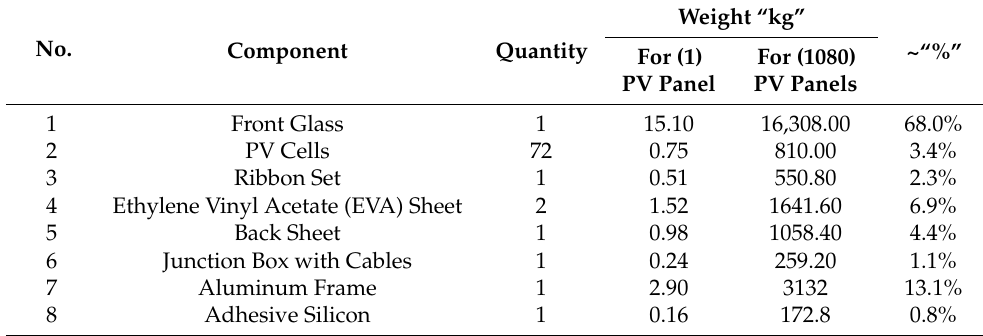
Table 4. Raw material contribution in the selected PV